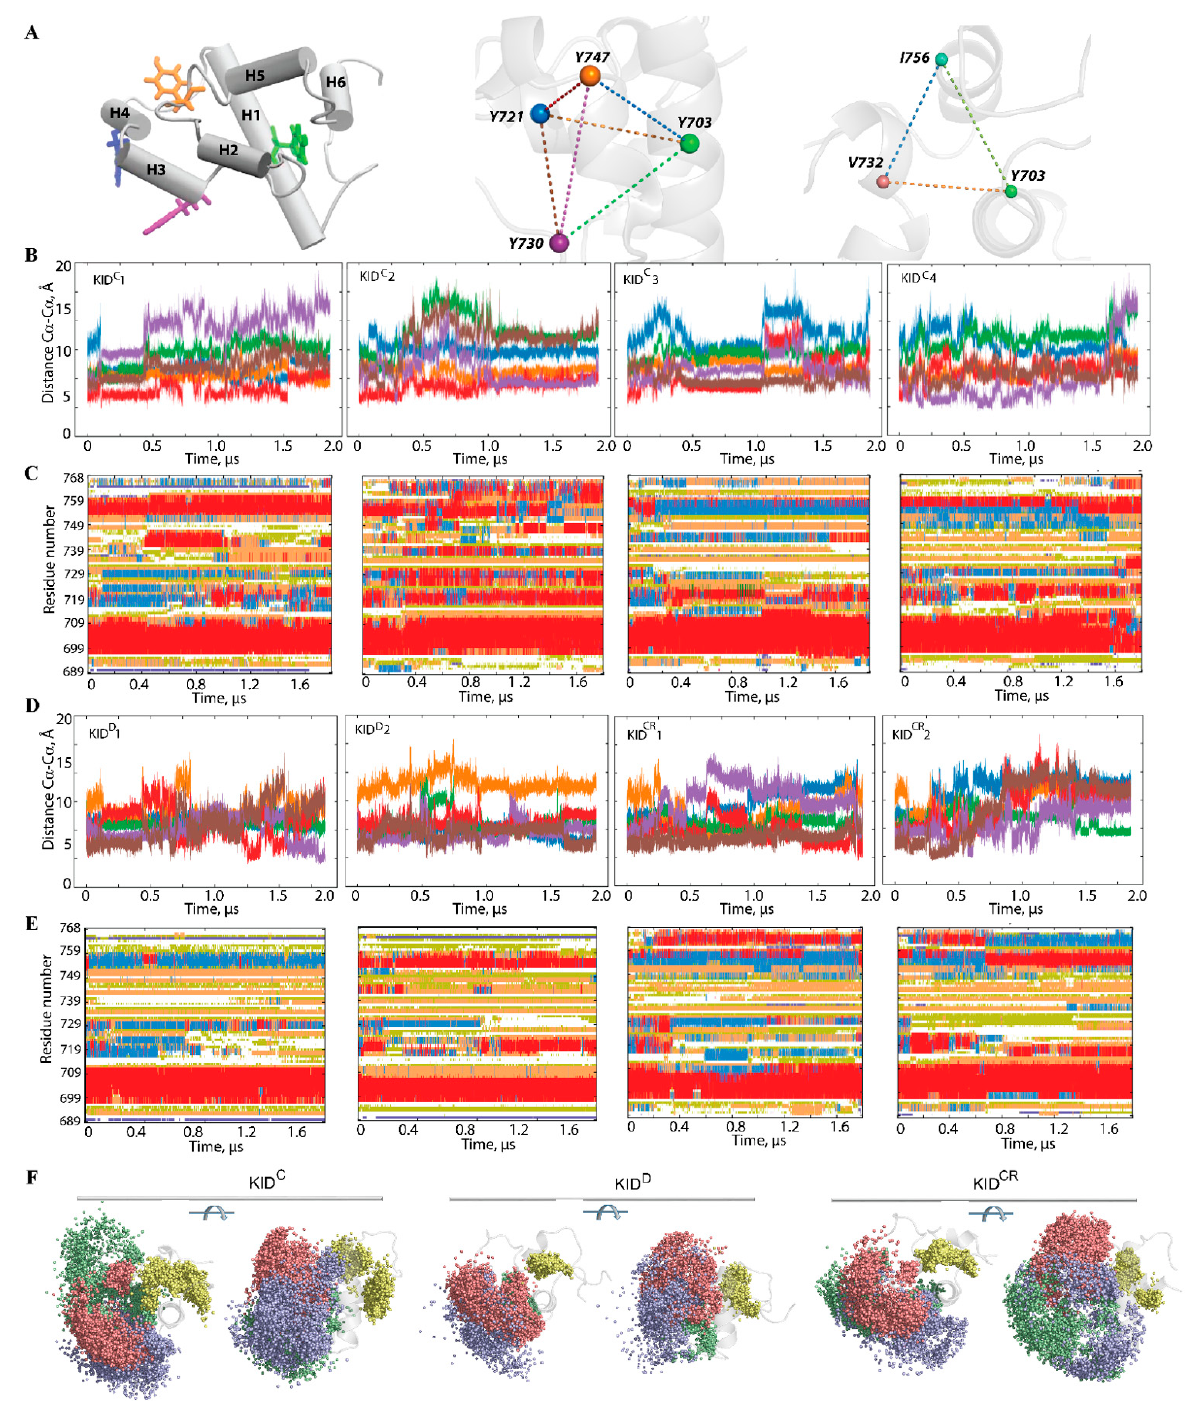
Figure 5. The inter-residue geometry of tyrosines in the isolated unconstrained KID and its relationship with folding. ( A ) KID structure with helices shown as solid cylinders and tyrosine residues as sticks (left), tetrahedron delimited on the C α -atoms of tyrosine residues (middle) and triangle designed on the most stable among the MD simulation residues (with the smallest RMSF values) (right). ( B , D ) Distances between each pair of tyrosine residues in each MD trajectory, coloured as the edges of the tetrahedron. ( C , E ) The time-related evolution of the secondary structures of each residue as assigned by DSSP with the type-coded secondary structure bar. ( D ) Distances between the most ‘stable’ (minimal RMSF values) residues Y703, V732 and I756 over each cMD trajectory, coloured as the edges of the triangle in ( A ). ( F ) The spatial distribution of hydroxyl groups presented by the oxygen atoms of the tyrosine residues in KID is shown in two orthogonal projections with the oxygen atoms of Y703, Y721, Y730 and Y747, respectively coloured in yellow, blue, red and